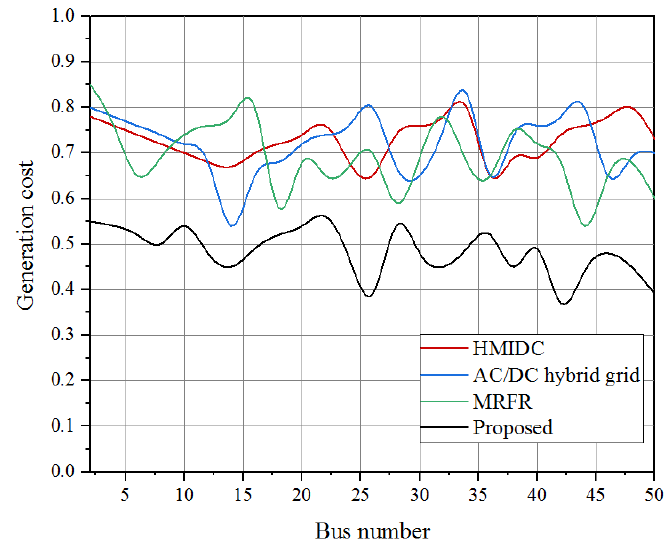
Figure 9. Convergence curves for generation cost of IEEE 50-bus system.